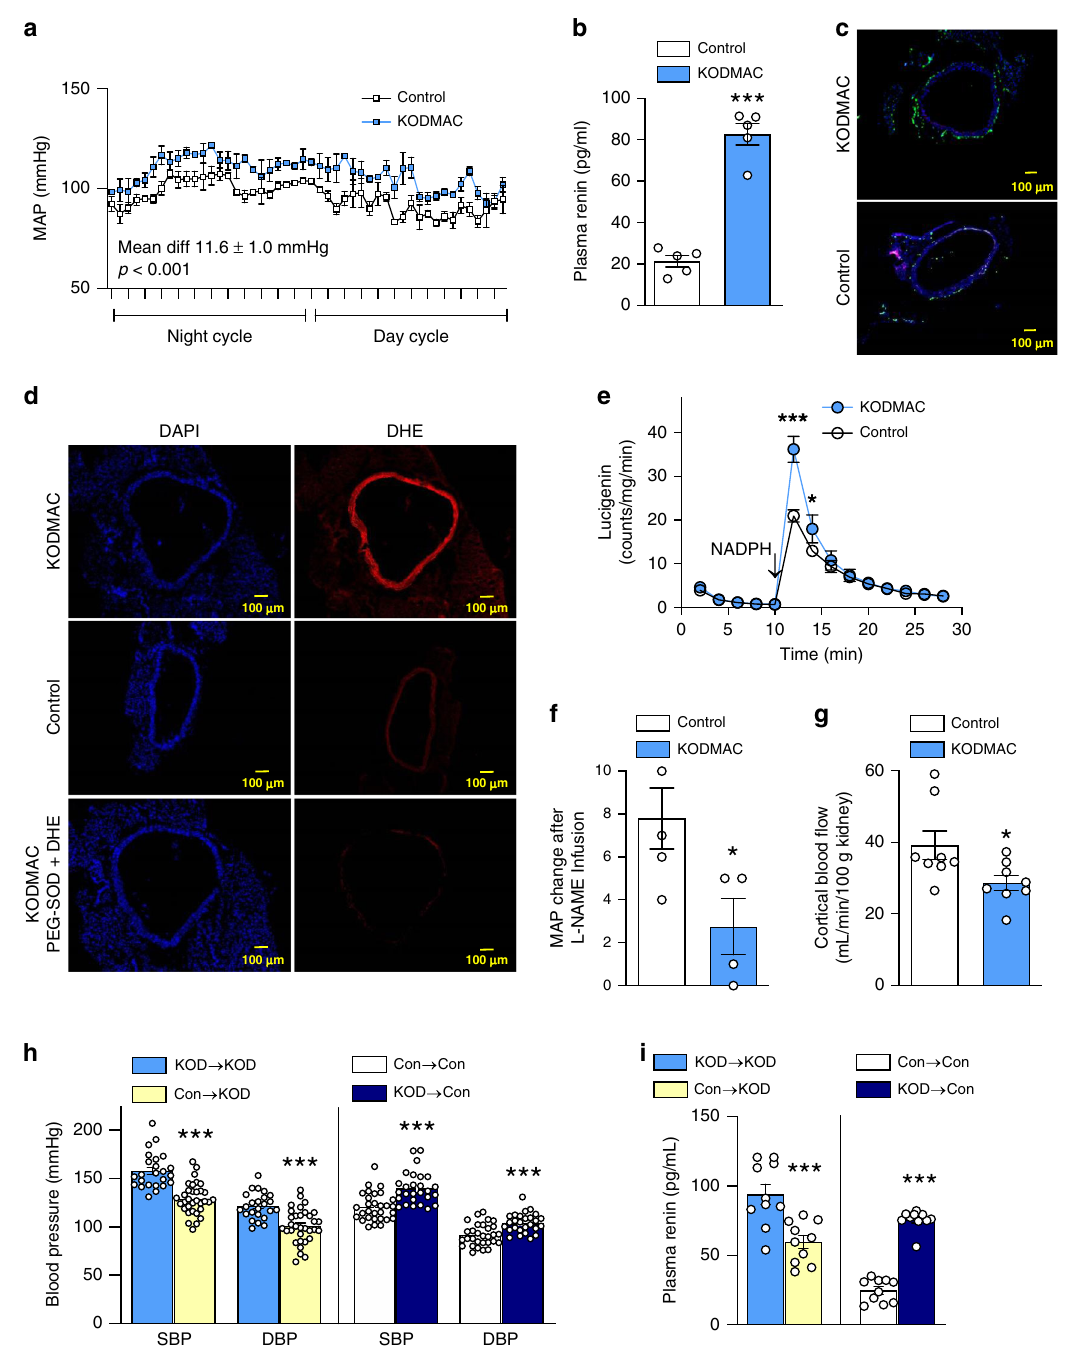
Fig. 1 Myeloid Vdr deletion induces hypertension by increasing vascular ROS. In 8-week-old KODMAC (light-blue bar) or control mice (white bar): a invasive mean arterial BP ( n = 3/group), b plasma renin ( n = 5/group), distal thoracic aortic assessment of ( c ) MOMA staining (green, DAPI = blue) (representative of four/group, scale bars: 100 µ m), d DHE staining (red, DAPI = blue) in the presence or absence of PEG-superoxide dismutase (representative of four/group, scale bars: 100 µ m), e NADPH-stimulated lucigenin-enhanced chemiluminescence ( n = 4/group), f increase in mean arterial blood pressure (MAP) with L-NAME ( n = 5 Con/4 KOD), and g renal cortical blood fl ow ( n = 8/group). Irradiated KODMAC mice transplanted with BM from KODMAC (KOD → KOD) (light-blue bar) or control (Con → KOD) (yellow bar) and irradiated control mice transplanted with BM from KODMAC (KOD → Con) (dark-blue bar) or control (Con → Con) (white bar). h Noninvasive BP ( n = 24 – 33/group) and i plasma renin ( n = 5/group). Data presented as mean ± SEM from ( a ) mixed model analysis, ( b – g ) Student ’ s two-tailed unpaired t test with * P < 0.05, *** P < 0.001 vs. control, and ( h , i ) Student ’ s two- tailed unpaired t test with *** P < 0.001 vs. matched donor/recipient control